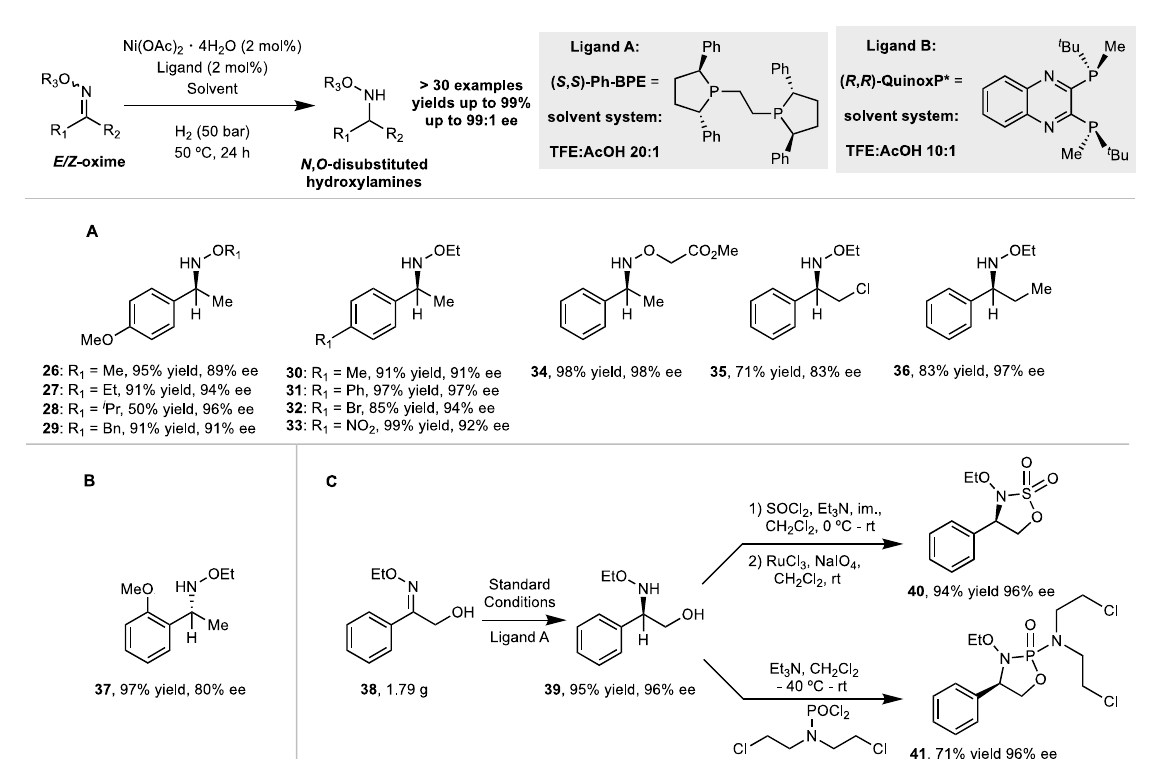
examples of the transformation using ligand system A. ( B ) Example of the transformation with an ortho -bearing substrate using ligand system B. ( C ) Gram-scale transformation and subsequent